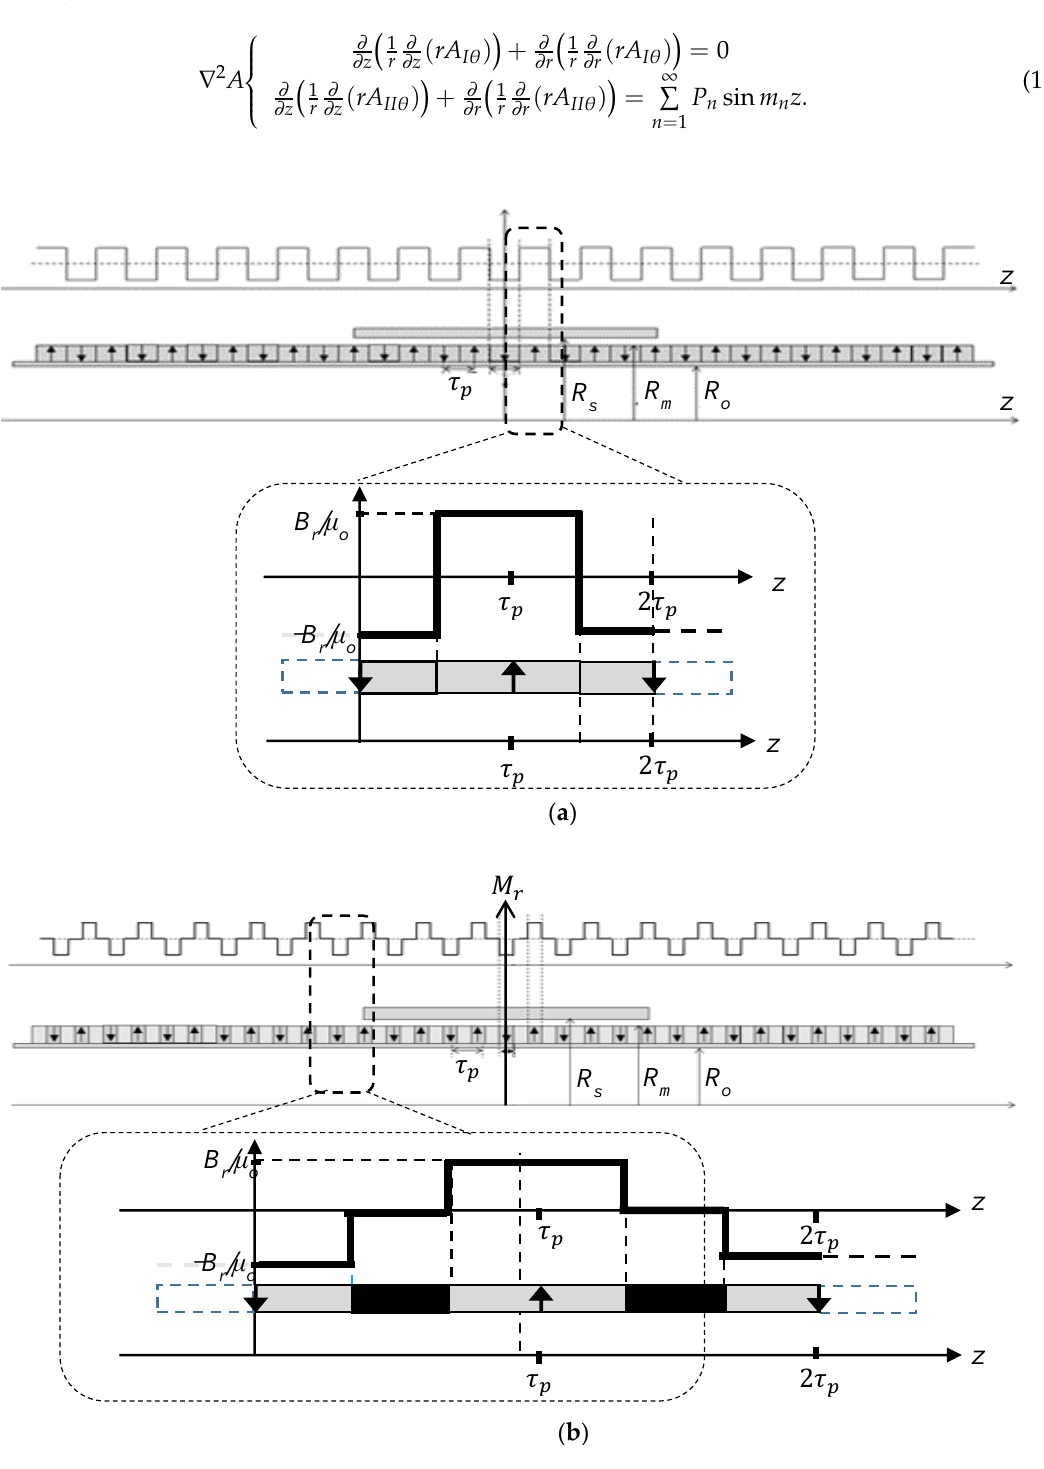
Figure 9. Magnetic Distribution of the Design Variants; ( a ) TPMLM-NS; ( b ) TPMLM-S.